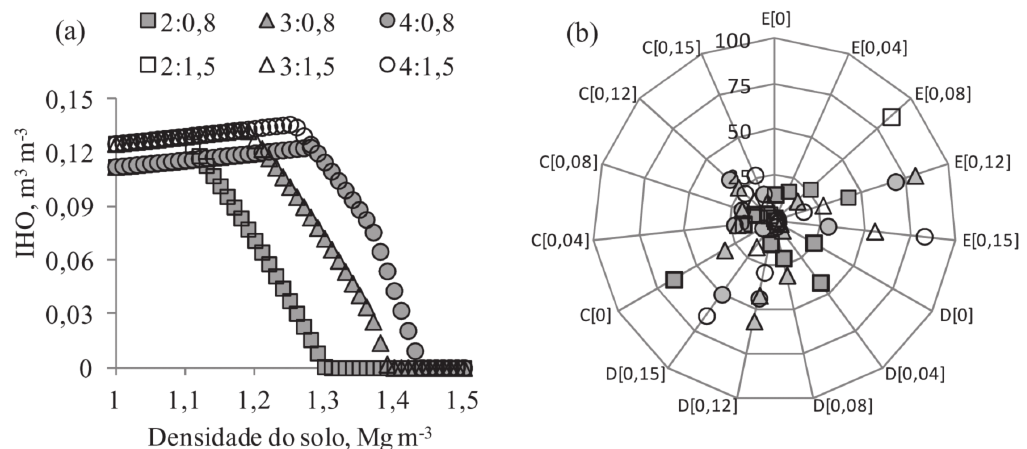
Figura 2. Intervalo hídrico ótimo (IHO) (a) e frequência de classes de IHO (b) para o conjunto de amostras das profundidades de 0,07 e 0,25 m em cada tratamento (E=PDE; D=PD; e C=PDC). A legenda é comum para ambos os gráficos e o primeiro e o segundo números representam, respectivamente, o valor da RP e do módulo de ψψψψψ usados no limite inferior do IHO. Números entre colchetes representam o limite superior de cada classe de IHO, cujo limite inferior está implícito a partir do limite superior da classe precedente (exceto para